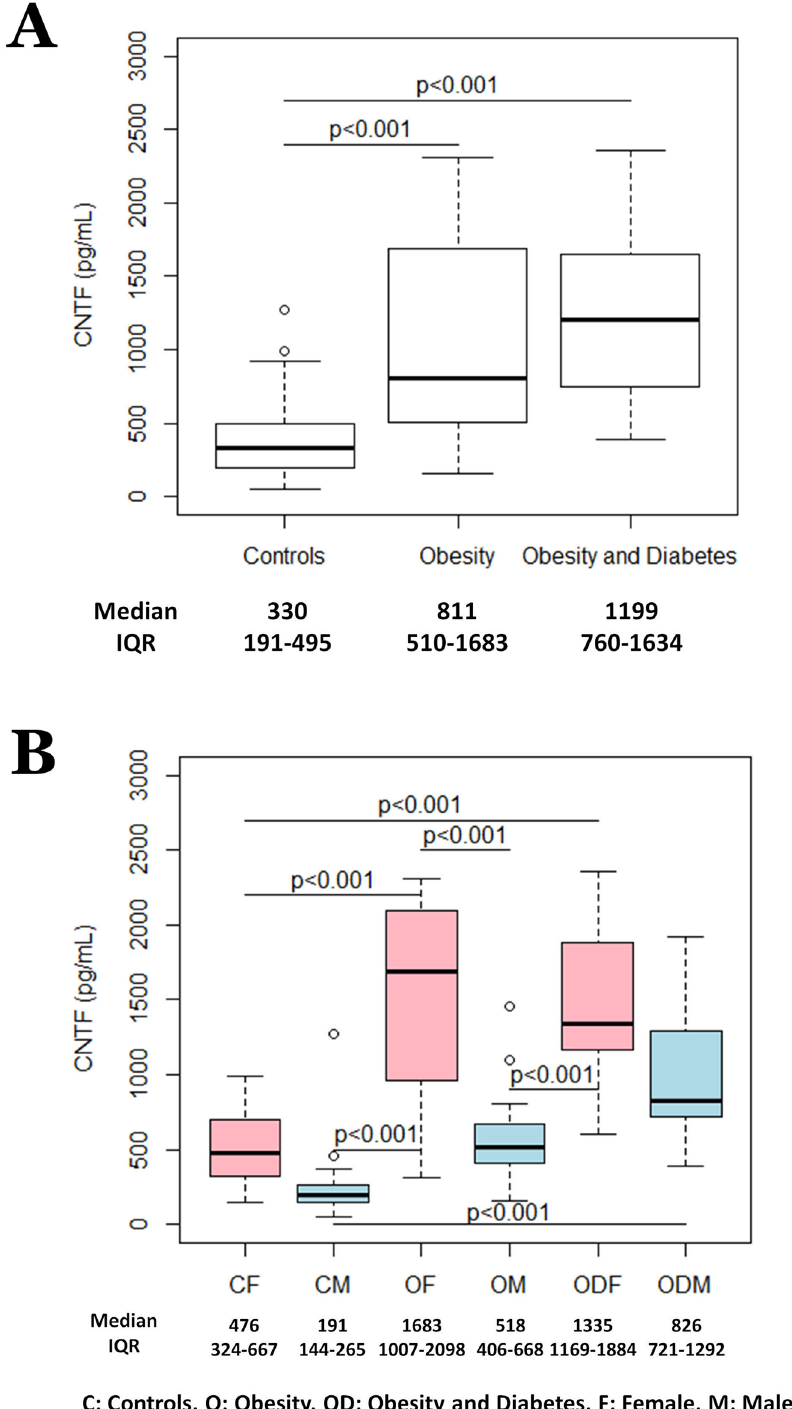
Figure 1. Distribution of plasma CNTF levels according to participants’ health condition ( A ) and health condition and gender ( B